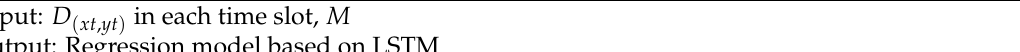
Algorithm 1 LSTM Based